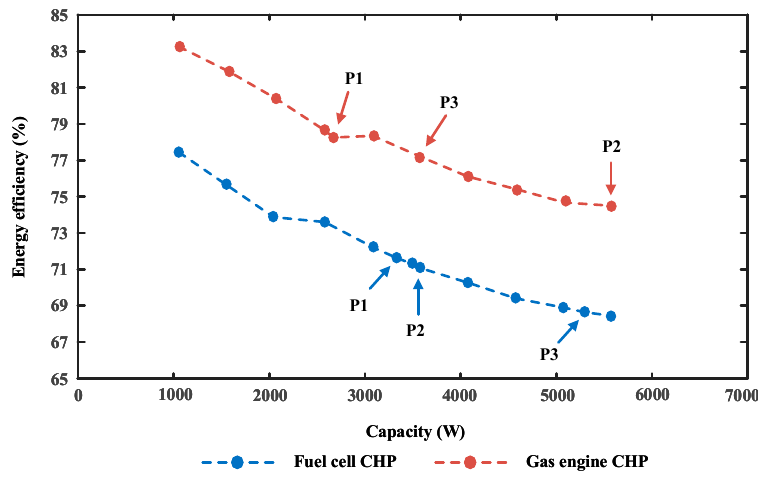
Figure 15. Effective CHP energy efficiency against CHP installation capacity.